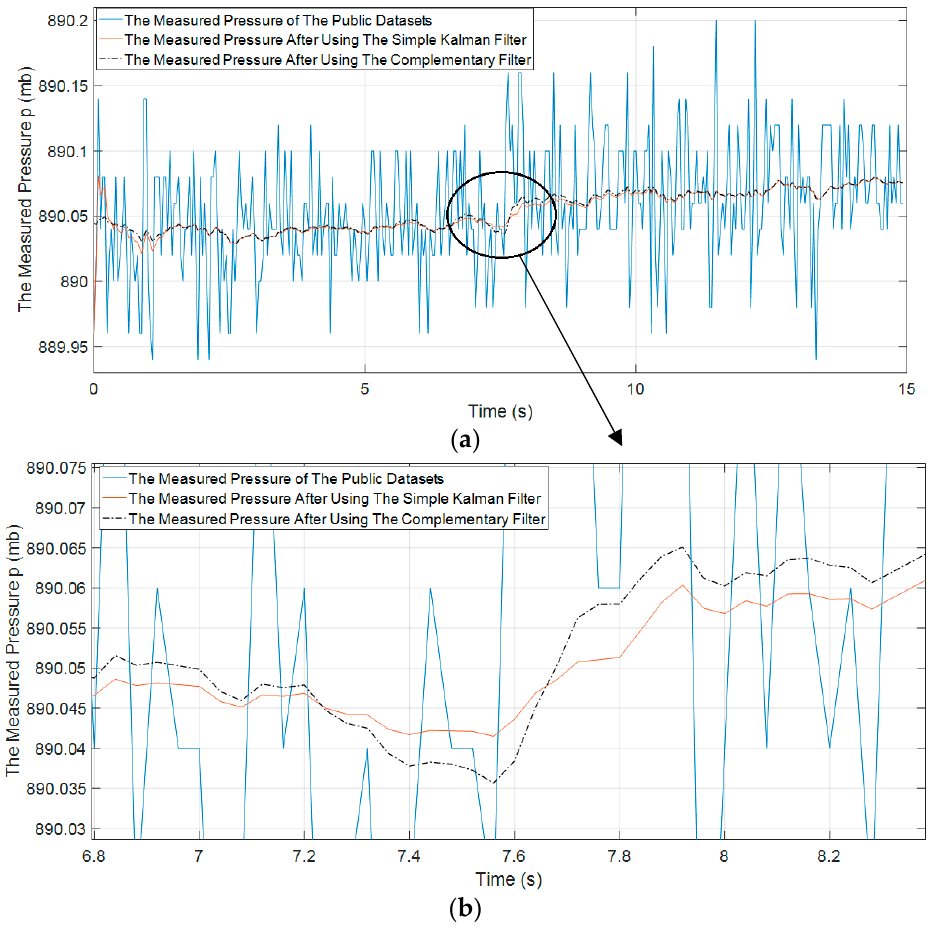
Figure 18. The measured pressure of the public dataset [31]; ( a ) the raw pressure data and estimated pressure data after using the simple Kalman filter and complementary filter, and ( b ) the zoom in raw pressure data and estimated pressure data after using the simple Kalman filter and complementary filter.